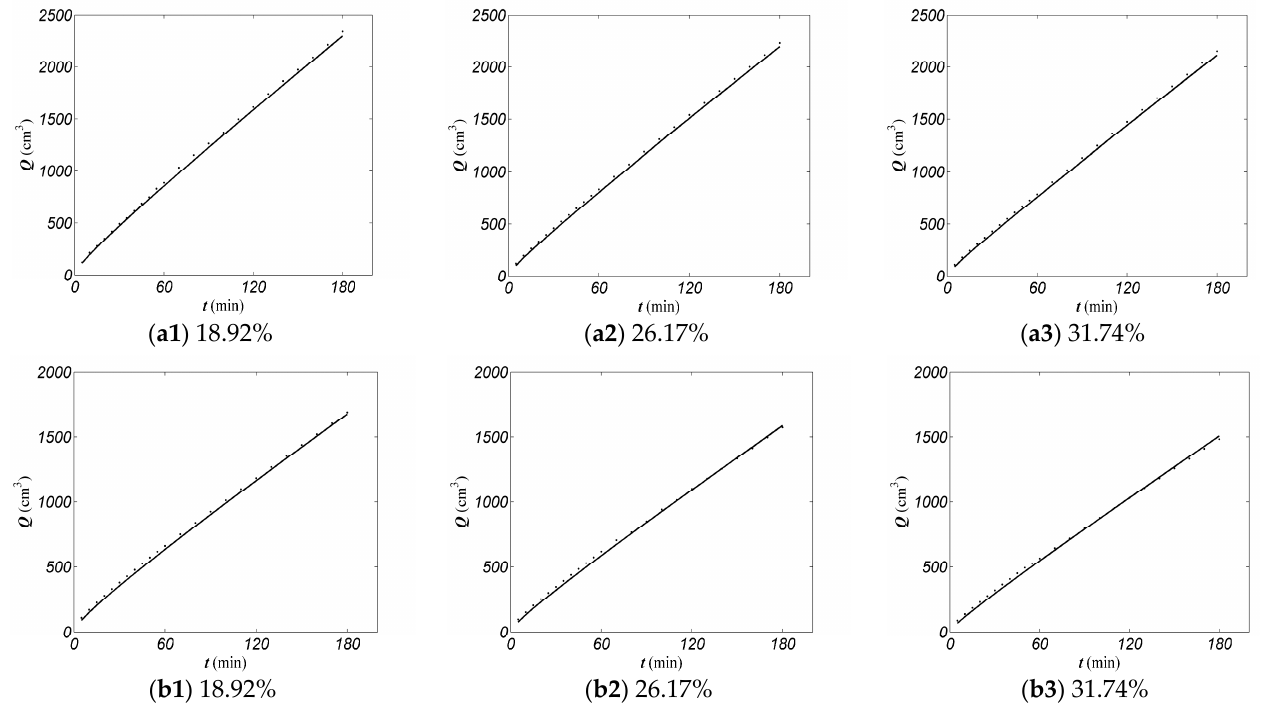
Figure 12. Comparison of cumulative infiltration for three initial water content levels.